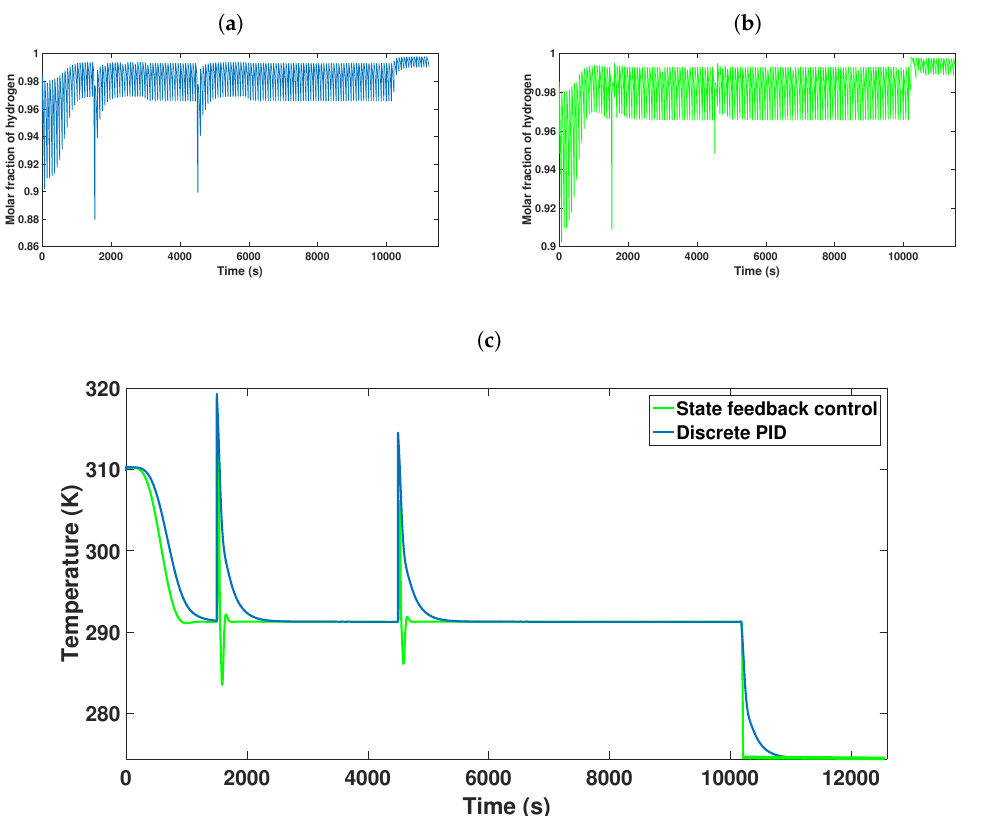
Figure 21. Validation of the controllers from two changes of trajectory and the presence of two disturbances. ( a ) Purity obtained with two trajectory tracking and attenuation of two disturbances from the control signals generated by the discrete PID. ( b ) Purity obtained with two trajectory tracking and attenuation of two disturbances from the control signals generated by state feedback. ( c ) Discrete PID and status feedback control